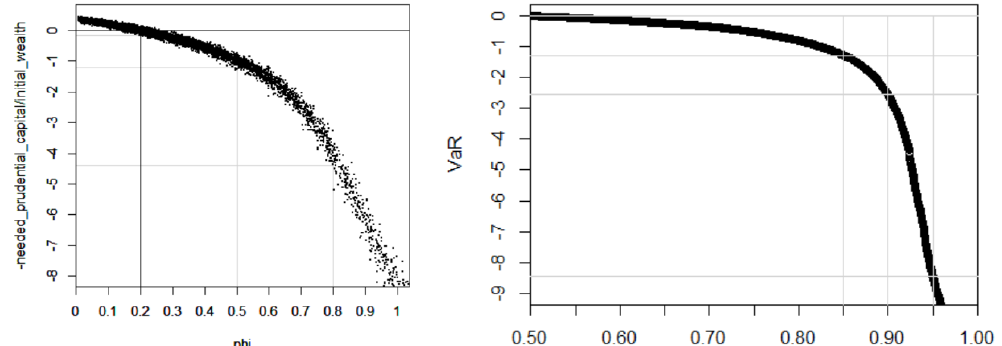
Figure 2. Needed prudential capital depending on the future longevity trend (or lack of) expressed as a proportion of the initial wealth. In the two graphs, the y-axis shows the present value of remaining wealth after paying retirement benefits for current employees, divided by the initial wealth of the pension fund: “−1” means that 100% of additional wealth would be needed today, i.e., a needed prudential capital of the size of the initial wealth. In the first graph, the x-axis shows different scenarios for the longevity trend φ and each dot in the graph is the result of a scenario. In the second graph, the x-axis is the level at which to compute the VaR that represents the needed prudential capital: for example, a 90% VaR over all